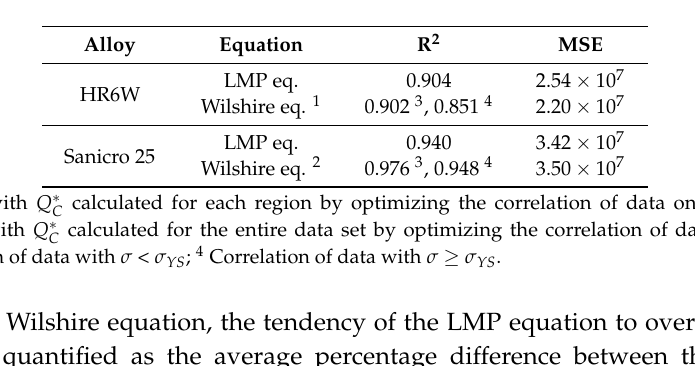
Table 7. Goodness of fit and error of Wilshire and LMP calculations.